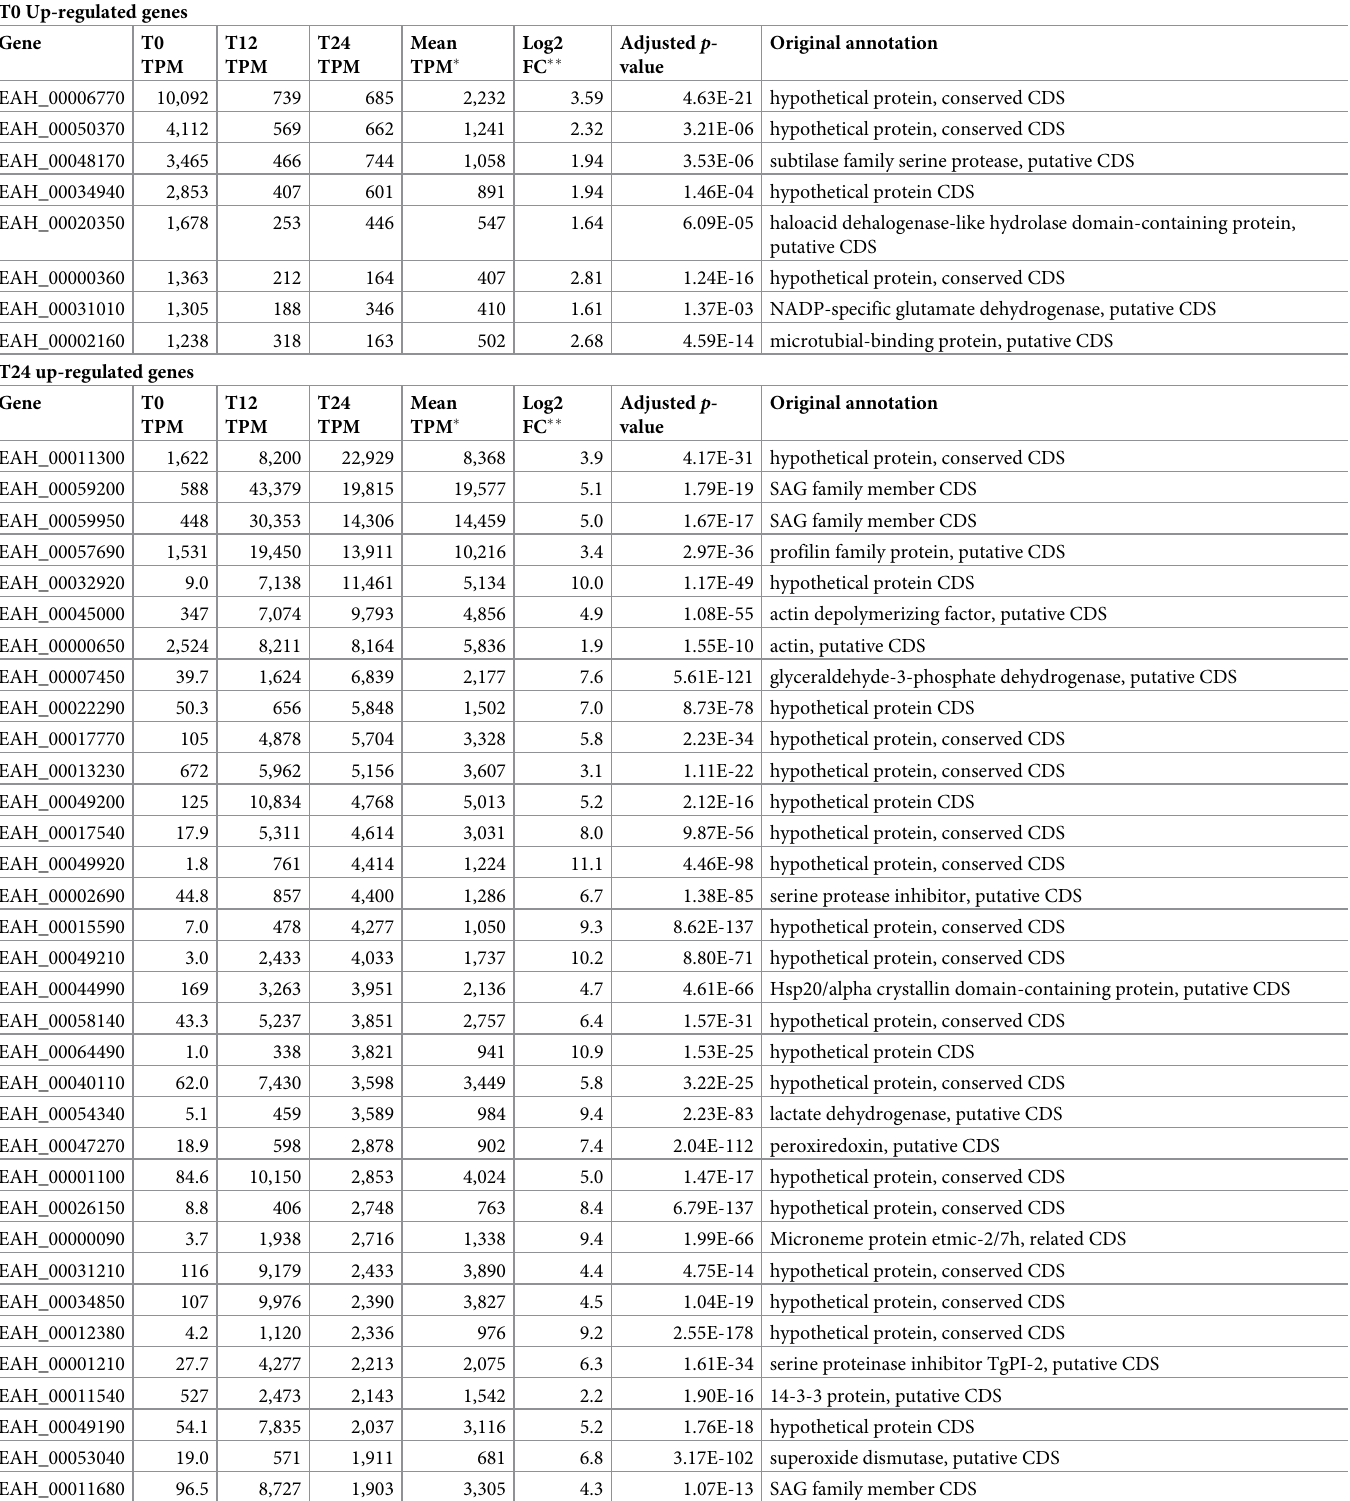
Table 3. Significantly differentially expressed genes between immature (T0) and mature (T24) E . acervulina